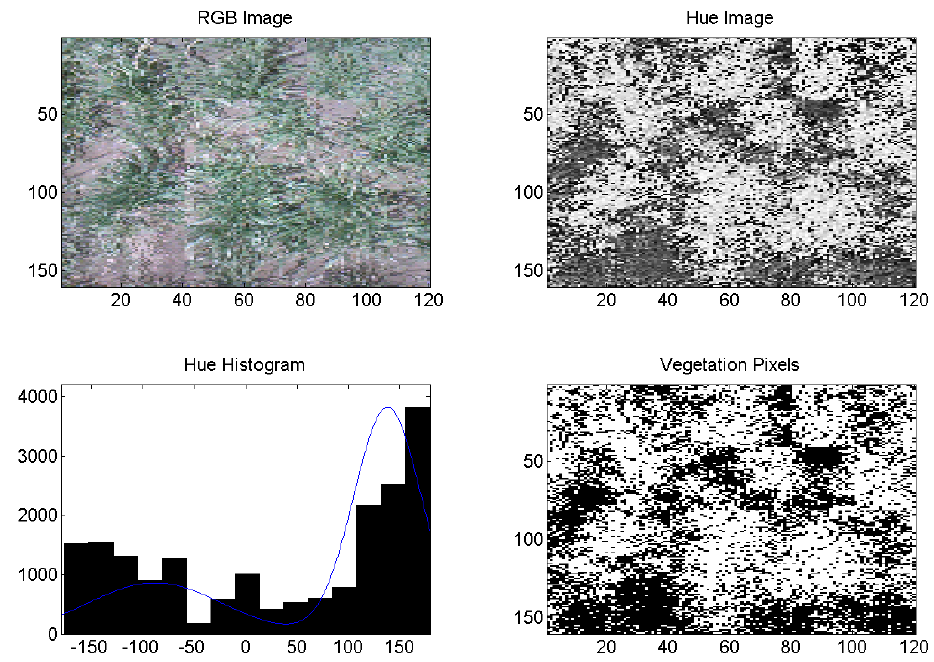
Figure 11. Example of wireless computer vision image analysis for wheat, DOY 88, 2013, healthy, 100%. Axes on images are in pixels.